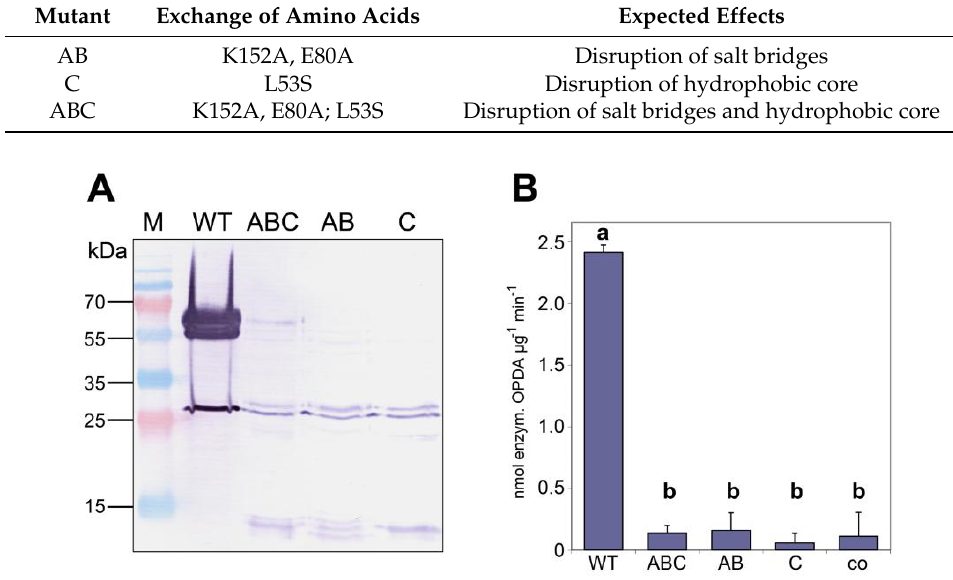
Figure 3. Monomers of AOC2 do not exhibit enzymatic activity. AOC2 was mutated to prevent trimer formation by the exchange of amino acids involved in salt bridge formation (K152A/E80A = “AB”), the formation of the hydrophobic core (L53S = “C”) or both (K152A/E80A/L53S = “ABC”) (see Table 1). ( A ) His-tagged recombinant proteins were treated with SDS at 42 °C for 5 min and separated on SDS-PAGE. Note that all mutant proteins are predominantly detectable as monomers. M = size marker. ( B ) AOC enzyme activity of recombinant wild-type AOC2 and mutant proteins. Each value is given as nmol of enzymatically-formed cis -(+)-12-oxophytodienoic acid (OPDA) per μg protein and min and is represented by the mean of three independent replicates ± SD. Different letters designate statistically-different values (one-way ANOVA with Tukey’s HSD test, p < 0.01). co = control done without the addition of protein to the reaction mixture.